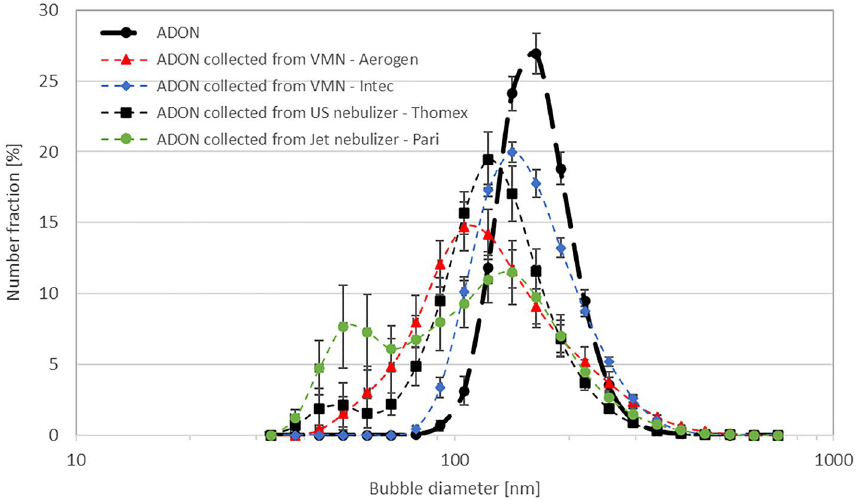
Figure 4. The comparison of densities of number size distributions of nanobubbles before and after nebulization in different nebulizers: vibrating mesh nebulizers (VMN)—Aerogen, and Intec, ultrasonic (US)— Thomex,